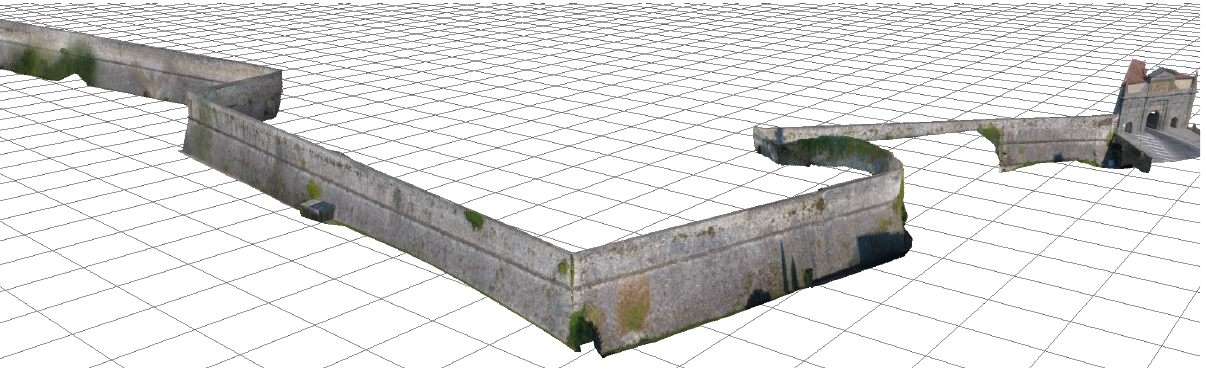
Figure 9. Portion of the walls model, with St. Michael’s bulwark, near to St. Augustine